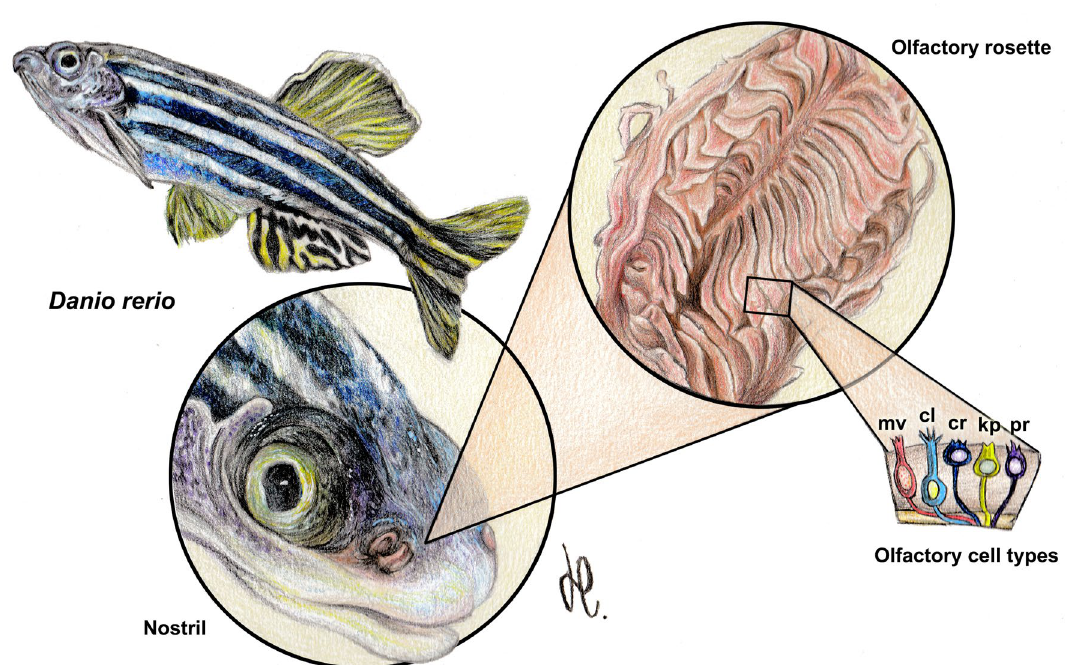
Figure 1. Macroscopic anatomy of the zebrafish olfactory organ. The olfactory rosette occupies in the head an anterodorsal position. The nostrils lie slightly rostral to the eyes and close to the mouth. Five neurosensorial olfactory cell types (OSNs) have been described: microvillous (mv); ciliated (cl); crypt (cr); kappe (kp); and pear (pr) OSNs. Drawing by Helena Reino Piñeiro published under a CC BY open access